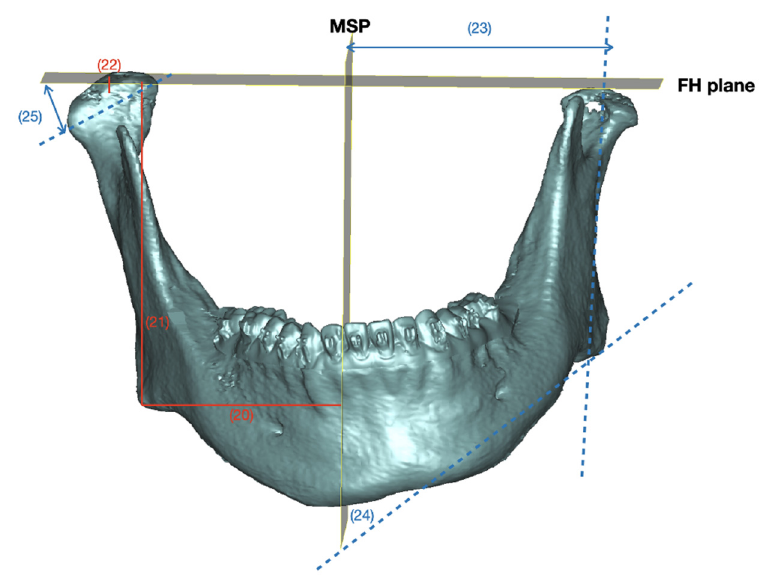
Figure 6. Mandibular measurements in frontal view. (20) Go to MSP, (21) Go to the FHP, (22) Co to the FHP, (23) Ramus axis to MSP, (24) Md axis to MSP, (25) condyle axis to the FHP.